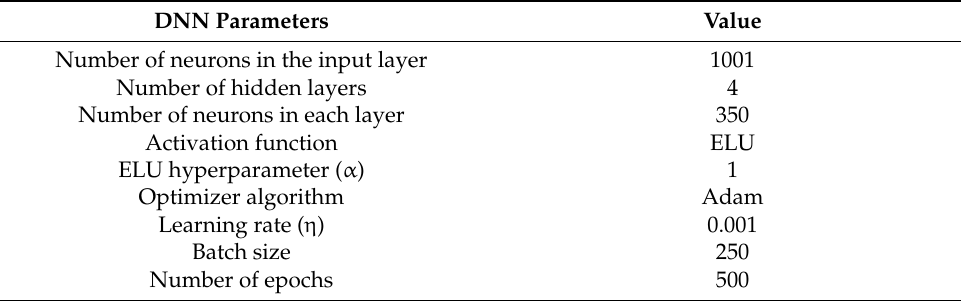
Figure 3. The DNN model performance in terms of loss and accuracy for training and validation dataset. Table 1. The deep neural network (DNN) parameters.